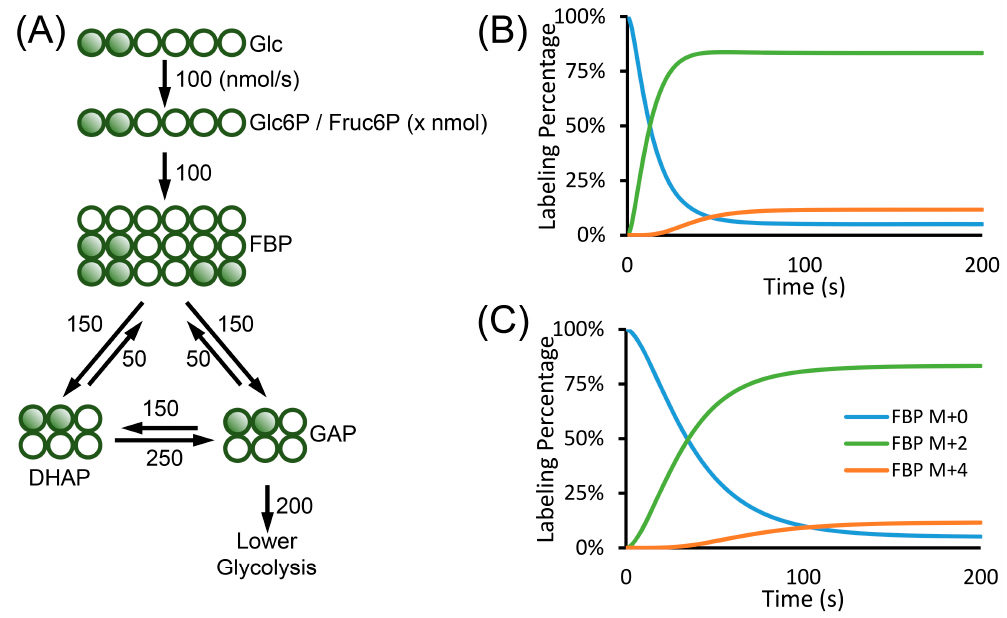
Figure 5. Example of isotopically non-stationary MFA. ( A ) Upper glycolysis network, the carbon sources were switched from non-labeled glucose to 1,2- 13 C 2 -glucose to measure the kinetics of metabolite labeling. The numbers next to the arrows are fluxes in the unit of nmol/s. ( B , C ) In isotopically non-stationary MFA, the labeling patterns of metabolite is affected by the pool size of the metabolites. FBP, DHAP and GAP all have the pool size of 1 µmol. The pool size of Glc6P is assumed to be 400 nmols ( B ) or 3000 nmols ( C ). ( B ) FBP in the network with small Glc6P pool size reaches steady state faster. ( C ) FBP in the network with large Glc6P pool size reaches steady state slower. The abbreviations used in the figure are: Glc, glucose; Glc6P, glucose-6-phosphate; Fruc6P, fructose-6-phosphate; FBP,